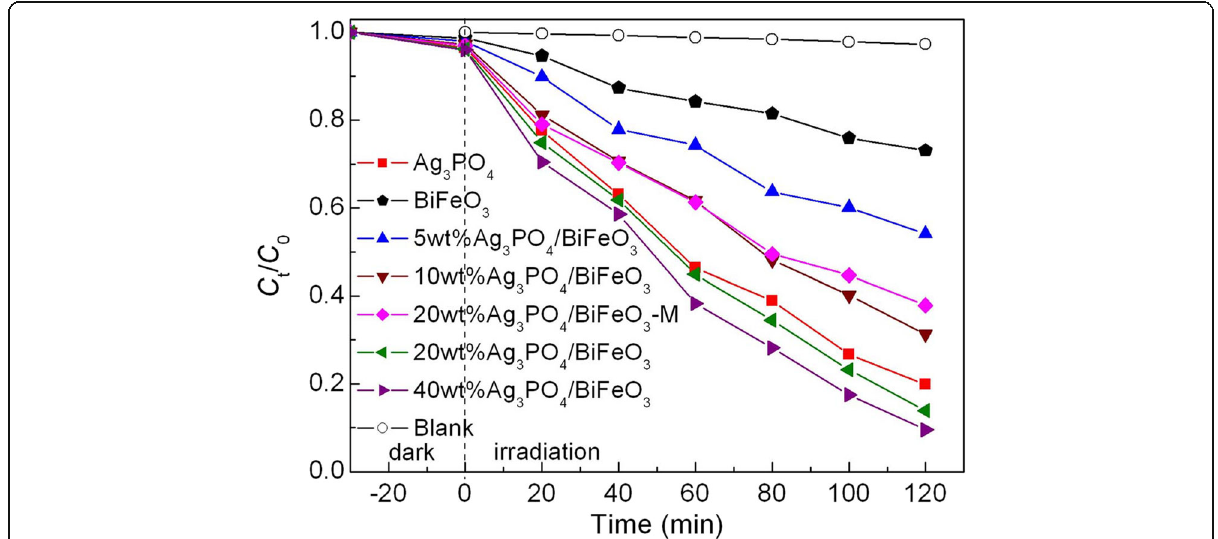
Fig. 5 Photocatalytic activities of BiFeO 3 and Ag 3 PO 4 /BiFeO 3 composites toward the degradation of AO7 under visible-light irradiation, along with the blank and absorption experiment